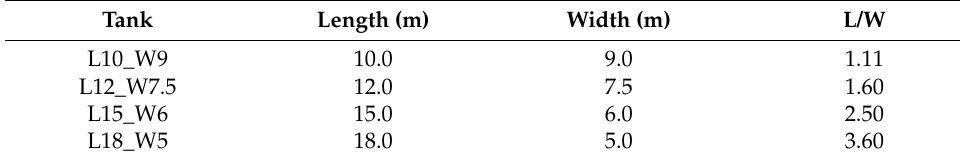
Figure 7. Wind rose of the computational grid containing the source. Table 2. The sizes of the four tanks.